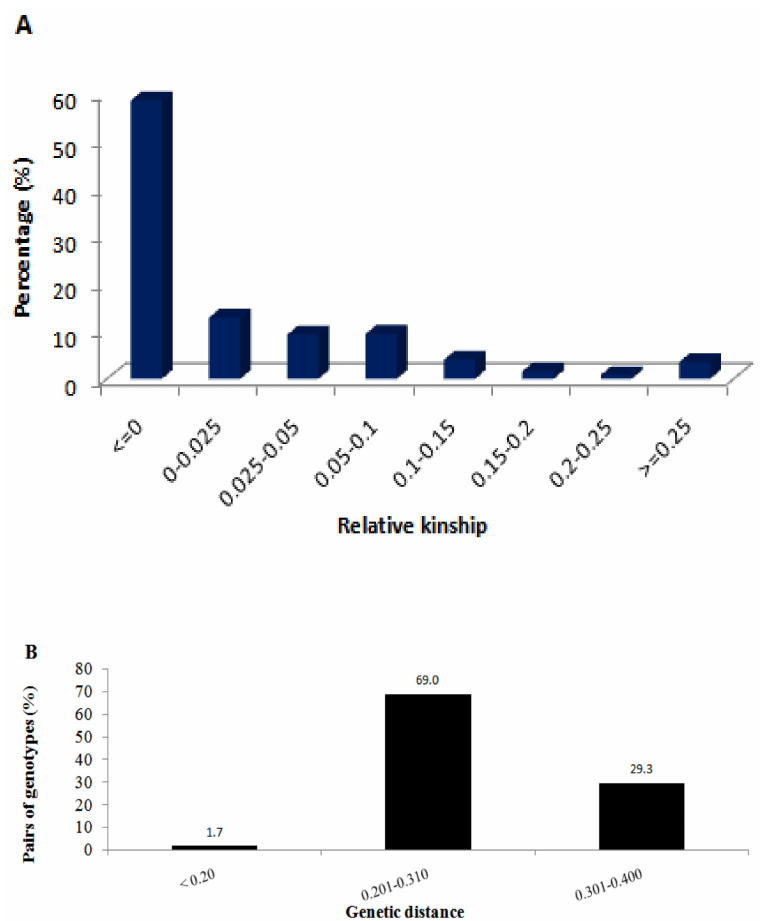
Figure 3. Summary of relative kinship and identity-by-state based genetic distance between pairs of the 384 inbred lines computed from 60,227 polymorphic SNPs. See Table S2 for genetic distance values and Table S3 for the pair-wise kinship between inbred lines.